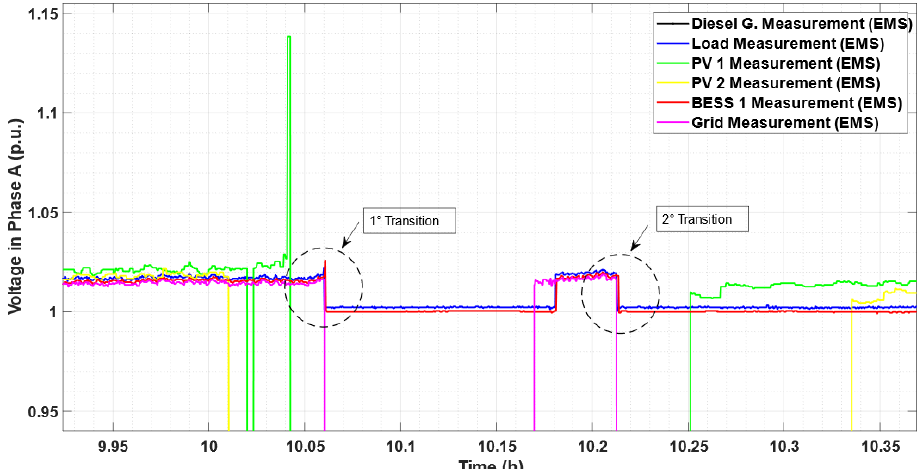
Figure 12. The voltage of microgrid components collected in EMS, focuses on transition operation.